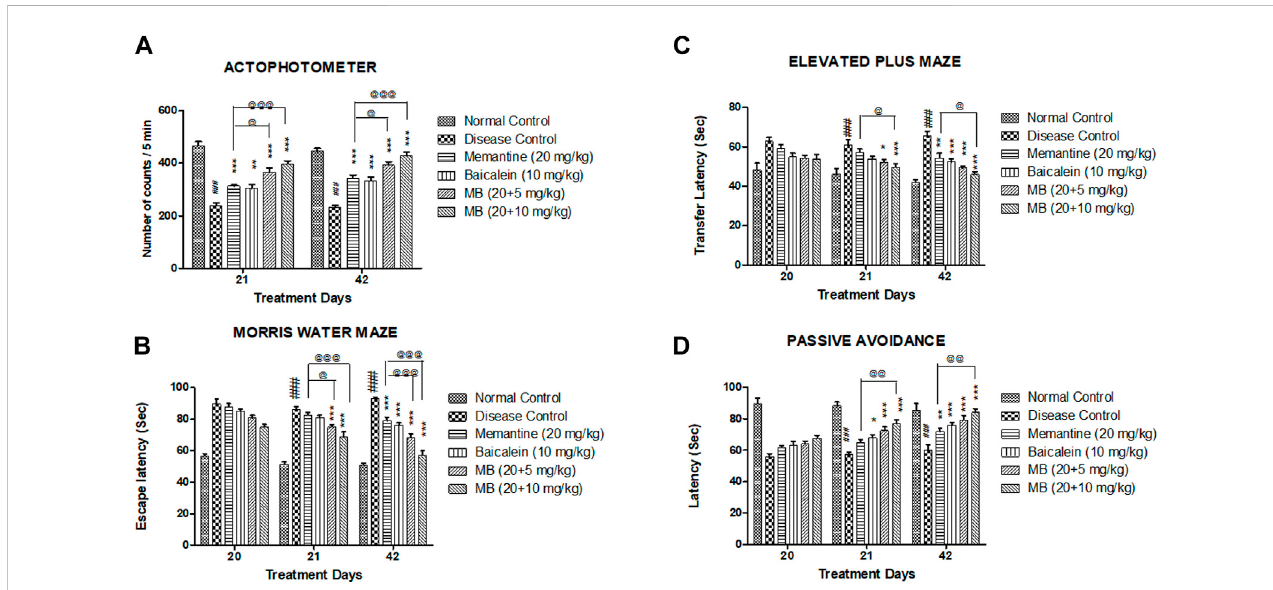
FIGURE 1 Effects of baicalein and baicalein with memantine on behavioral assessment. (A) Actophotometer, (B) Morris Water Maze, (C) Elevated Plus Maze, (D) Passive Avoidance. Data are expressed as mean ± SEM ( n = 6), with ### p < 0.001 when compared to the normal control group, * p < 0.05, ** p < 0.01, and